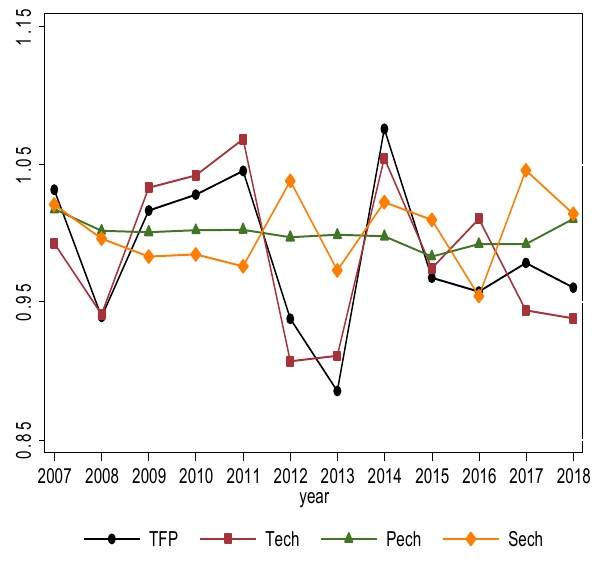
Figure 6. Trends in Production Efficiency of Late Indica Rice from 2007 to 2018.